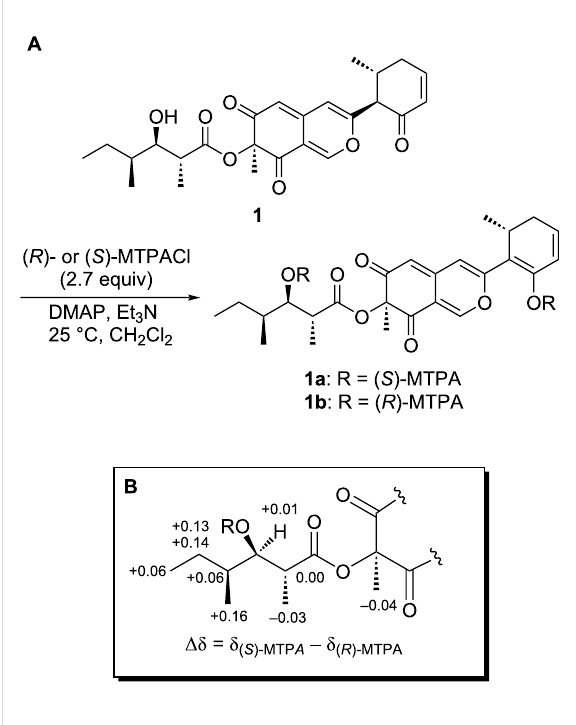
Scheme 1: (A) Synthesis of MTPA diesters 1a and 1b . (B) Δδ Values for the ( S )- and ( R )-MTPA esters of 1 .